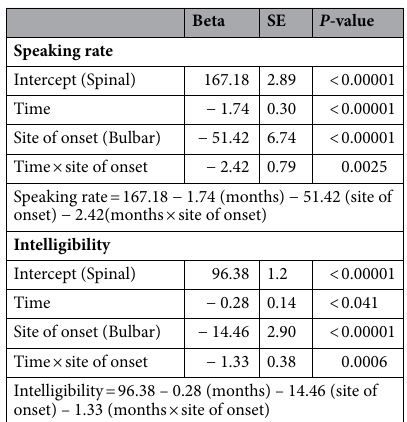
Table 4. LMEs model estimates accounting for the effect of site of onset and its interaction with time (i.e., months relative to baseline) on functional speech measures.